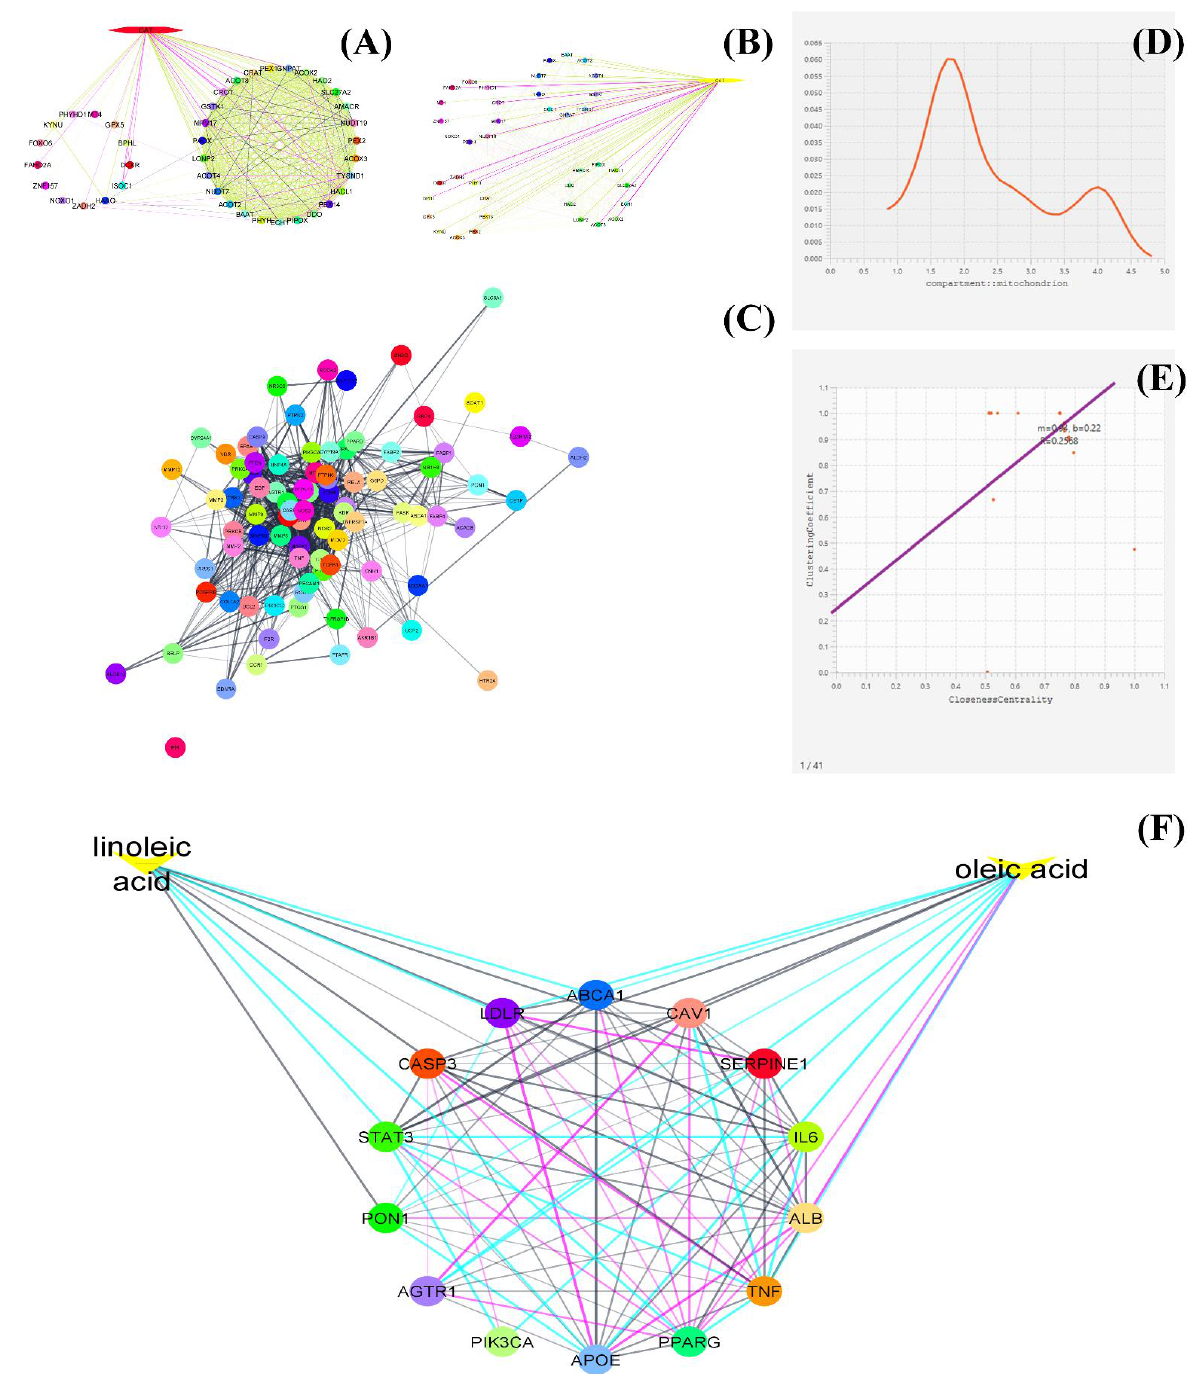
Figure 3. A systematic approach for network biology and pharmacology of phytochemicals, ( A ) represents the untargeted genes PPI network with partial interaction (small circle) and significant interaction (big circle), ( B ) represents selective PPI network with the specific protein (CAT) while ( C ) represents the common PPI network with partial and significant interaction of proteins/genes. ( D ) represents the histogram of the analyzed proteins based on their enrichment concerning cellular compartments (mitochondria), while ( E ) represents the regression analysis of the analyzed genes between clustering coefficient and closeness centrality. ( F ) represents the CPI interaction network which represents the interaction of two phytoconstituents with specific genes in the form of different colored edges. Each color of the edges represents a different database source. Each figure was generated as an example through the Cytoscape